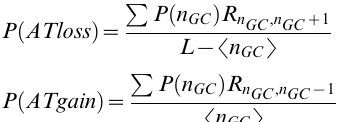
Figure S3 Yeast substitution rates are robustly correlated with the flanking nucleotides for all substitution types. Shown are the inferred substitution rates in TSS distal low occupancy sequences for the S. cerevisiae lineage (the gray lineage, x axis), and other sensu stricto lineages (color coded, Y axis), for 16 different flanking nucleotide contexts. The linear fit (dashed line) slopes for each lineage is roughly proportional to its branch length, but the model allows for differences in the substitution rates among lineages. A) A- . C, T- . G substitutions B) A- . G, T- . C substitutions C) A- . T, T- . A substitutions D) C- . A, G- . T substitutions E) C- . G, G- . C substitutions F) C- . T, G- . A substitutions. Figure S4 A/T gain and loss substitution rates at low and high occupancy loci. Shown are ratios of all substitution rates in low vs. high occupancy loci (Y axis) plotted against the substitution rates at high occupancy loci (X axis) over TSS proximal (A) and distal sequences (B). Each point represents the rate of one substitution (color coded) in loci flanked by the 3 9 and 5 9 nucleotide depicted above the data point. C,D) Substitution rates by their A/T dynamics in TSS proximal (C) and distal (D) loci. Error bars depict the standard deviation. The trends are identical over transitions and transversions. Figure S5 A/T gain and loss dynamics in different lineages of the sensu stricto clade. A-F) A/T loss and A/T gain rates over TSS distal (bars) and proximal (gray ticks) for the lineages leading to the following species: S. cerevisiae (A), S. paradoxus (B), S.mikatae (C), S. kudriazevii (D), the common ancestor of S. cerevisiae & S. paradoxus (E), and the common ancestor of S. cerevisiae & S. mikatae (F). G-L) Shown are the average G + C content of the following extant species and inferred ancestors, depicted for 10 levels of S. cerevisiae nucleosome occupancy (Methods): S. cerevisiae (G), S. paradoxus (H), S.mikatae (I), S. kudriazevii (J) the common ancestor of S. cerevisiae & S. paradoxus (K) and the common ancestor of S. cerevisiae & S. mikatae (L). Figure S6 G/C trinucleotides in TSS proximal low occupancy loci are more likely to be bound by a transcription factor. Shown is the fraction of G/C trinucleotides that are bound by one of the following transcription factors: REB1, UME6, MSN2, MBP1 within TSS distal high occupancy loci (-H), TSS distal low occupancy loci (-L), TSS proximal high occupancy loci ( + H), and TSS proximal low occupancy loci ( + L). Figure S7 Coupling of A/T gaining and A/T losing substitu- tions at TSS-distal sequences. A) Shown is a comparison of the rate of A/T gaining substitutions near inferred sites of A/T losing (black) and A/T gaining (red) substitution, plotted for different ranges of nucleosomes occupancy (X axis). B) Similar analysis of A/T loss substitution rates around inferred A/T gain and A/T loss events. Figure S8 Theoretical evolutionary model. A-H) Evolutionary simulation in high G + C fitness landscape. Shown are results of a simulation identical to the one described in Figure 5, with the fitness landscape changed to reflect optimality at a G + C content of 40% (higher than the 30% neutral content). I) Theoretical evolutionary model recapitulates the empirical A/T content dynamics observed in the Wright-Fischer simulation. Shown are the substitution rates for each selection intensity of A/T